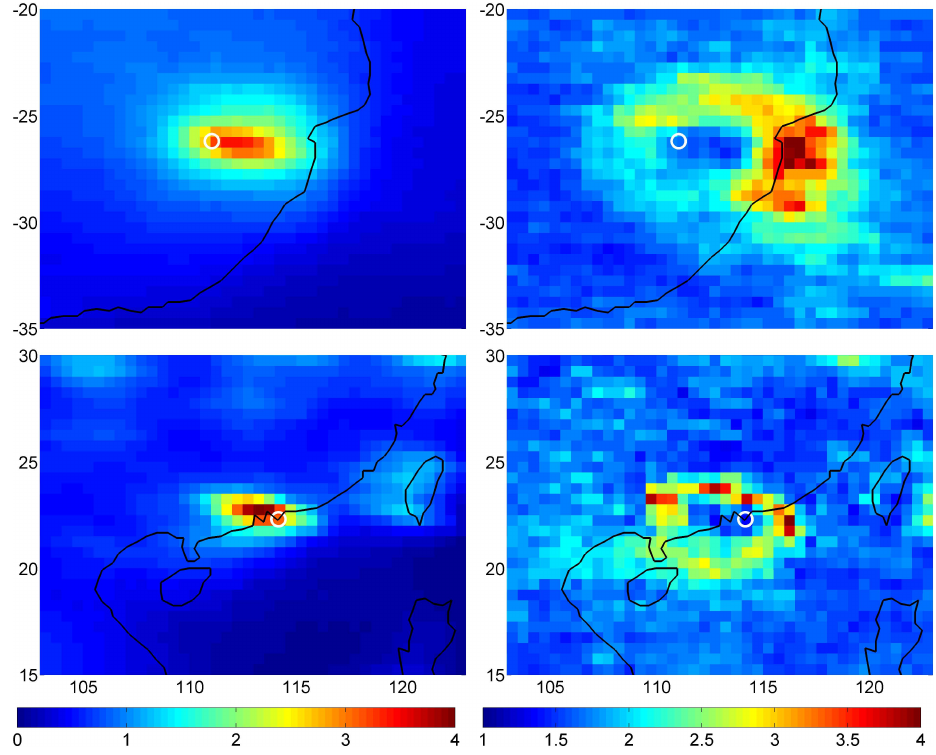
Fig. 1. Left: Mean tropospheric vertical column density (TVCD) of NO 2 (10 15 molec/cm 2 ) around Johannesburg (top) and Hong Kong (bottom). Right: Ratio of standard deviation over MAD (median absolute deviance) for the respective regions. The high ratios between the two variability measures around the local minimum of the sources are consequences of transport processes. High values indicate that the transport is dominated by relatively few, though large